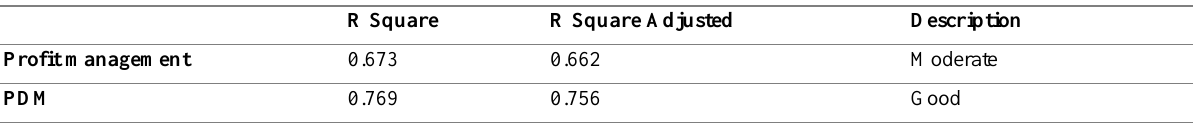
Table 6: Test R Square